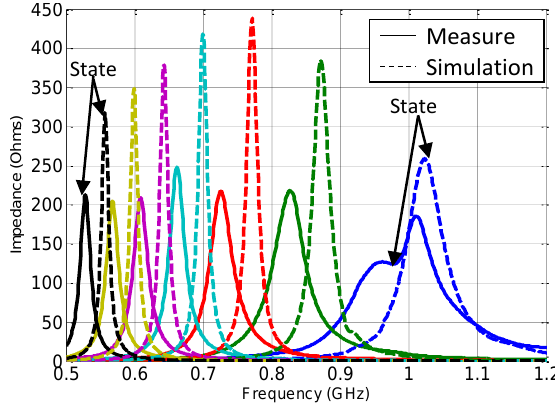
Figure. 7. Comparison of simulated and measured antenna input impedance (real part)